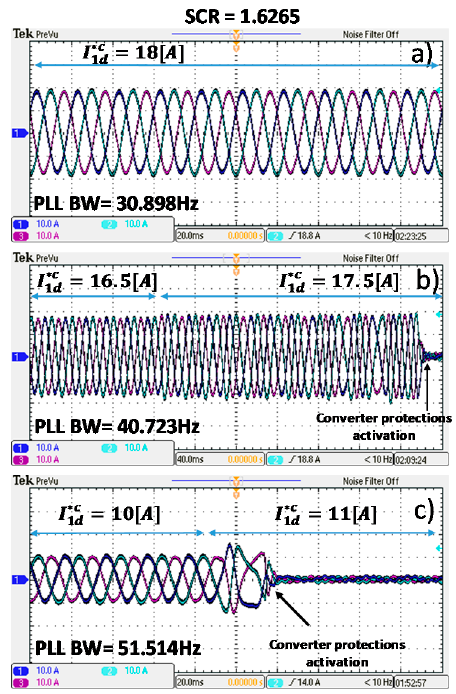
Figure 12. Experimental results: ( a ) Maximum active current injected by the converter into the grid with PLL bandwidth of 30.898 Hz (10 A/div); ( b ) Maximum active current with PLL bandwidth of 40.723 Hz (10 A/div), ( c ) Maximum active current with PLL bandwidth of 51.514 Hz (10 A/div).